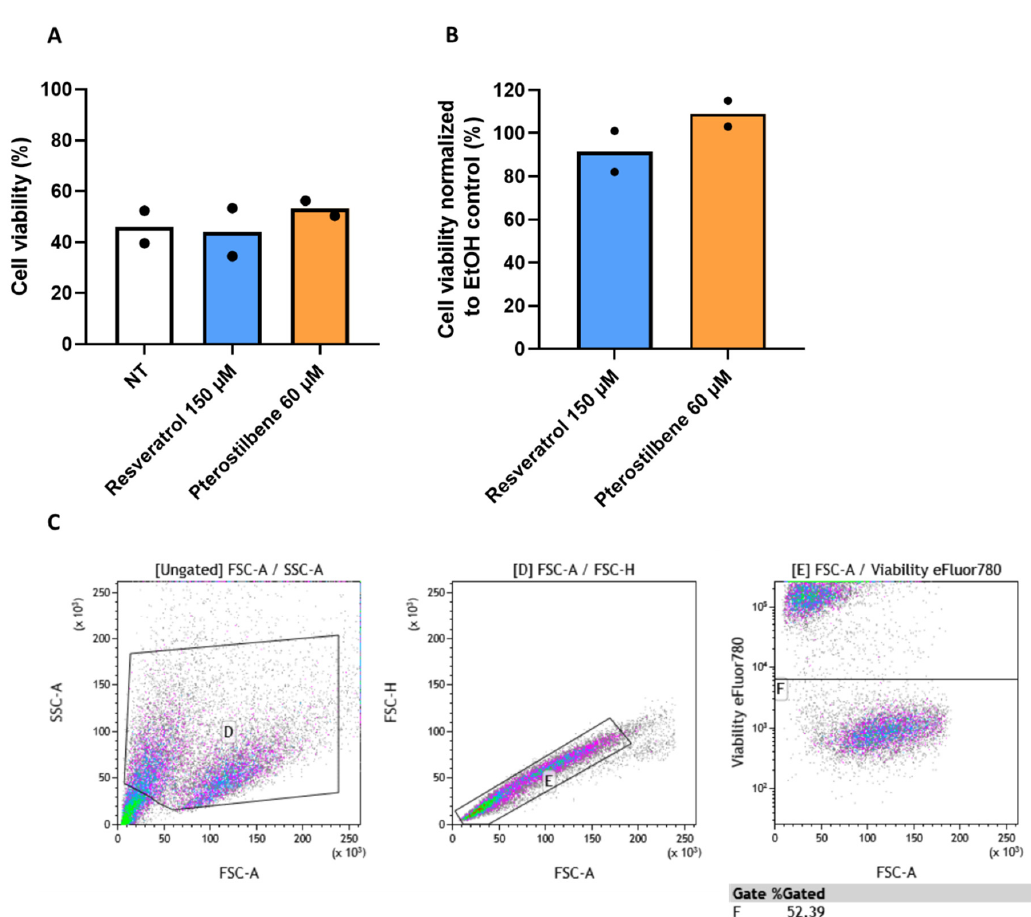
Figure A4. Cellular cytotoxicity of resveratrol and pterostilbene in PBECs. PBECs were incubated in absence (non-treated, NT) or presence of 150 µM resveratrol and 60 µM pterostilbene at basolateral side for 48 h. Cell viability was assessed by flow cytometry using ( A ) life/death staining and ( B ) a LDH assay. ( C ) Gating strategy flow cytometry. Cell population was gated with gate D; doublets were excluded with gate E; live population was determined with gate F. Data represents mean ± SEM, symbols represent two independent